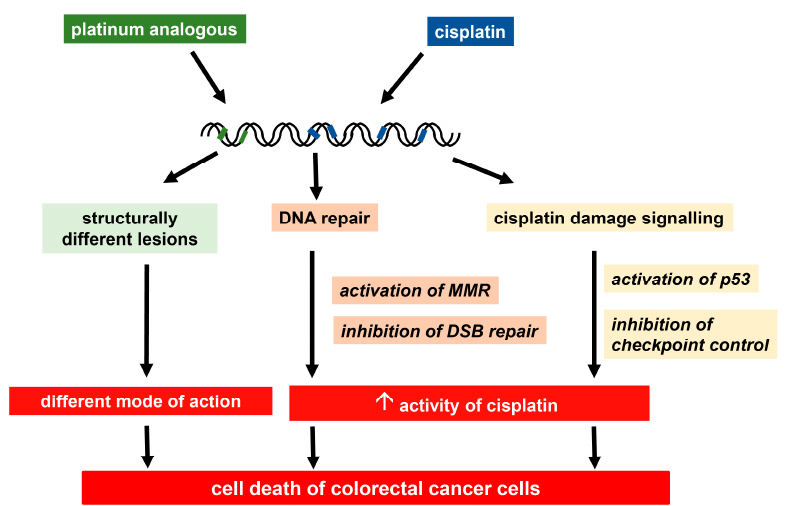
Figure 5. Targeting cisplatin resistance in colorectal cancer cells. Cisplatin-derived Pt (II) and Pt (IV) complexes induce structurally different DNA lesions resulting in a different mode of action compared to cisplatin and hence cell death in cisplatin-resistant colorectal cancer cells. Interfering with the DNA repair via activation of mismatch repair (MMR) or inactivation of double strand break (DSB) repair and targeting cisplatin damage signaling by activation of p53 or inactivation of cell cycle checkpoint control the increase in activity of cisplatin and lead to cell death in colorectal cancer cells.